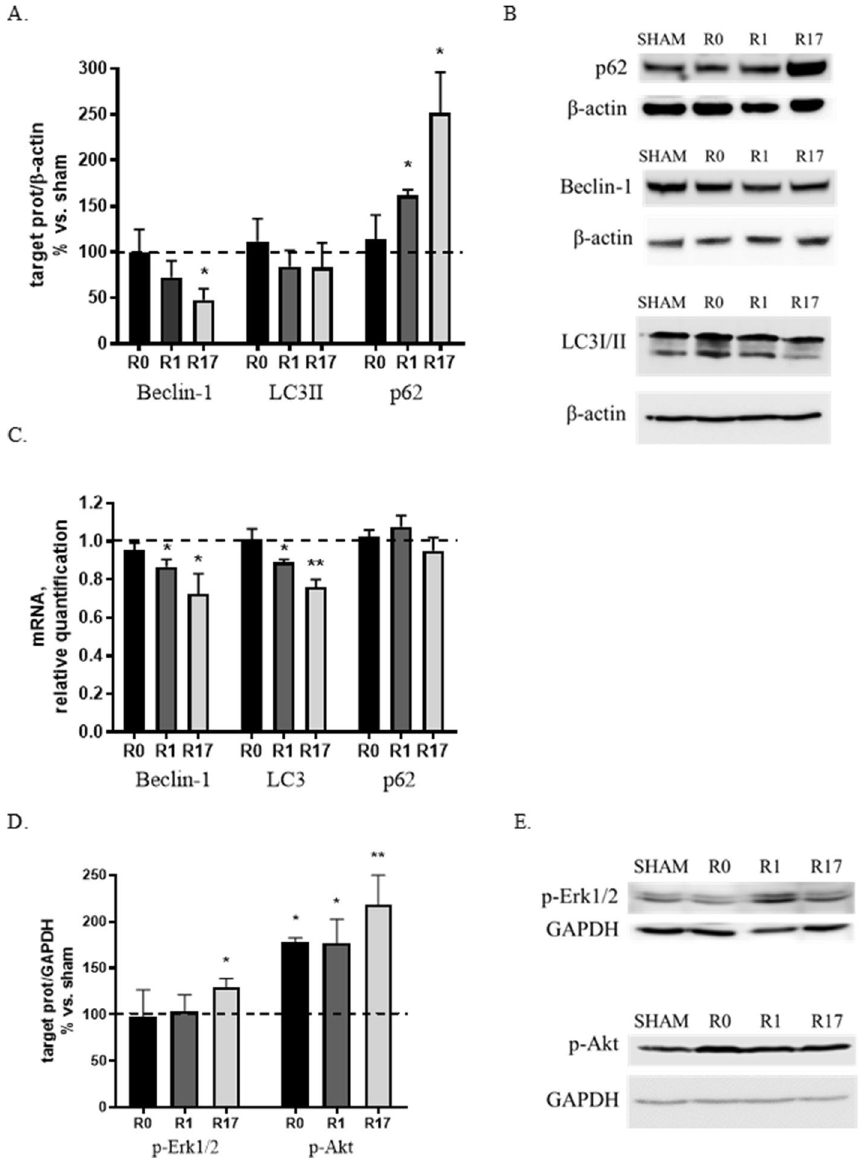
Figure 2. Effects of DCS on protein and gene expression of macroautophagy markers (Beclin-1, LC3, p62) ( A , C ) and on the activation/phosphorylation of 2 regulatory pathways (Erk1/2, Akt) ( D , E ) in SH-SY5Y cells under basal conditions at the end of stimulation (R0), after 1 and 17 h (R1 and R17). A down-regulation of macroautophagy was found in DCS-treated cells. ( B ) Representative Western blot image showing immunoreactivity at different time points (R0, R1 and R17) for p62, Beclin-1, LC3 and β-actin, used as internal standard, in cells exposed to DCS or sham. Full-length blots are presented in Supplementary M&M. ( E ) Representative Western blot image showing immunoreactivity at different time points (R0, R1 and R17) for phosho-Akt, phospho-Erk1/2 and GAPDH, used as internal standard, in cells exposed to DCS or sham. Full- length blot for phospho-Akt and available cropped blot for phospho-Erk1/2 are presented in Supplementary M&M. (N = 3; **p < 0.01, *p < 0.05 vs.